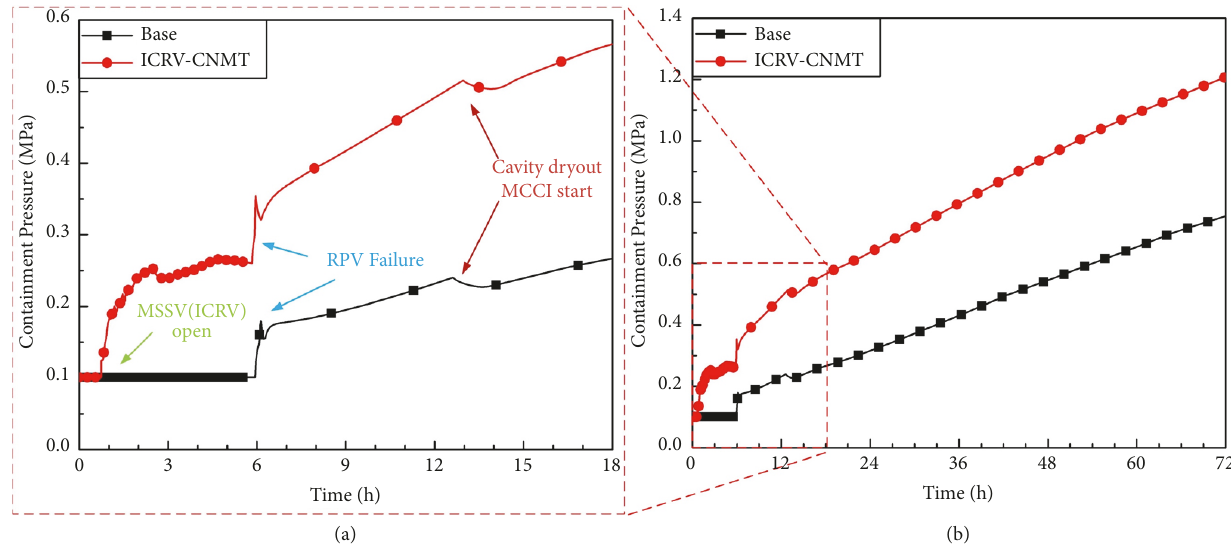
Figure 12: Comparison of containment pressure: (a) first 18 hours; (b) full 72 hours.